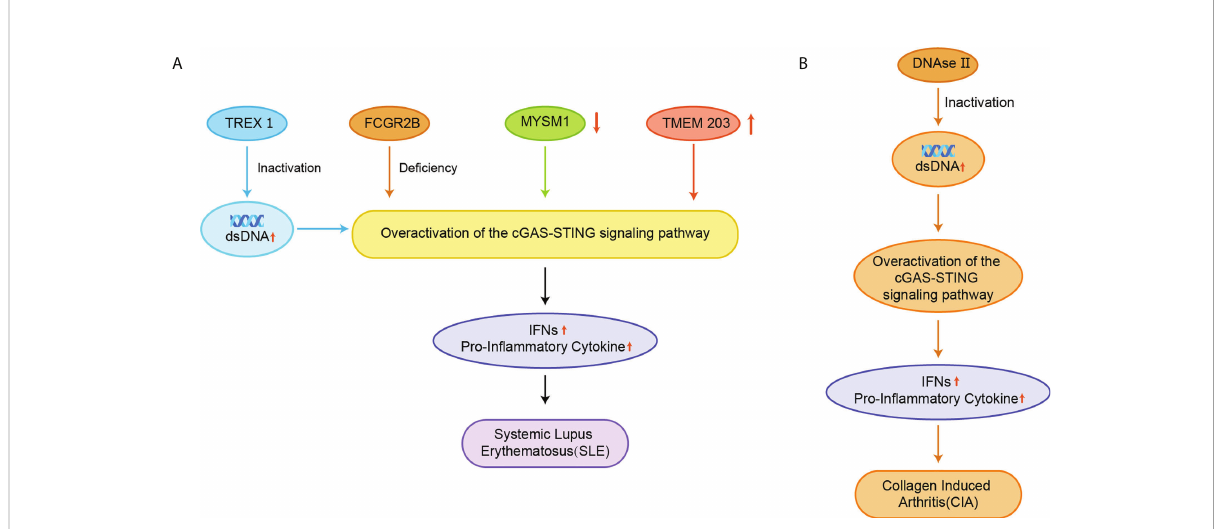
FIGURE 7 (A) Inactivation of TREX1 resulted in the accumulation of AdMVs in serum, deletion of the FCGR2B gene, decreased MYSM1 production in PBMC, and elevated TMEM203 signaling in T cells were associated with overexpression of the cGAS-STING signaling pathway, upregulation of IFNs and pro-in fl ammatory cytokine expression, and induction of SLE; (B) Inactivation of DNase II causes abnormal accumulation of dsDNA, which over- activates the cGAS-STING signaling pathway and triggers